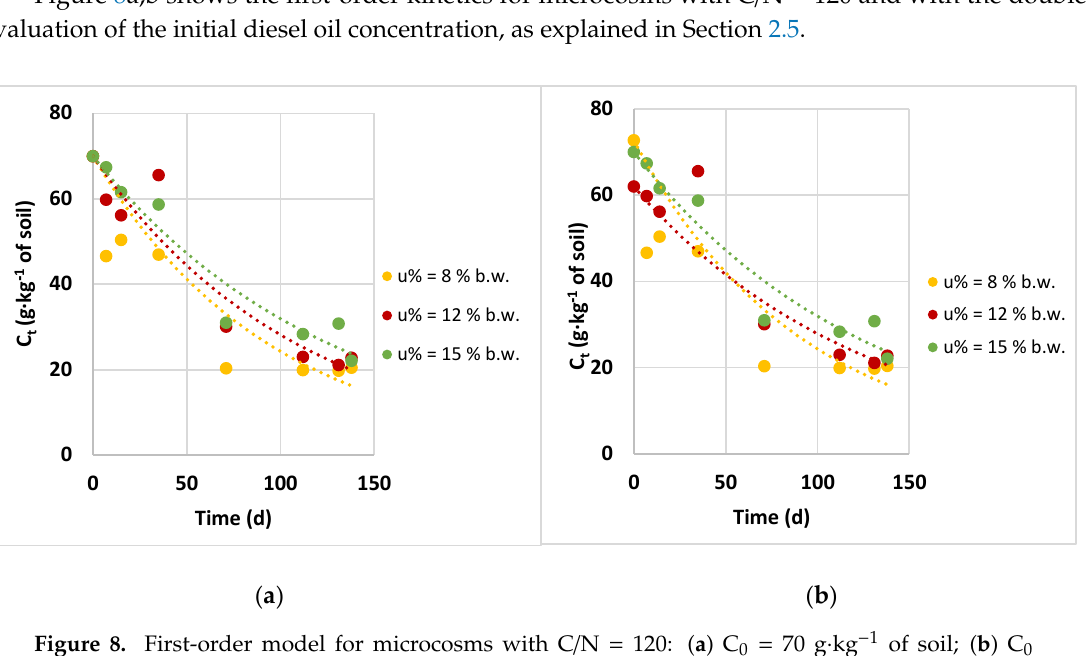
Table 5. First-order reaction rate constants and half-life times for microcosms with C/N = 120.